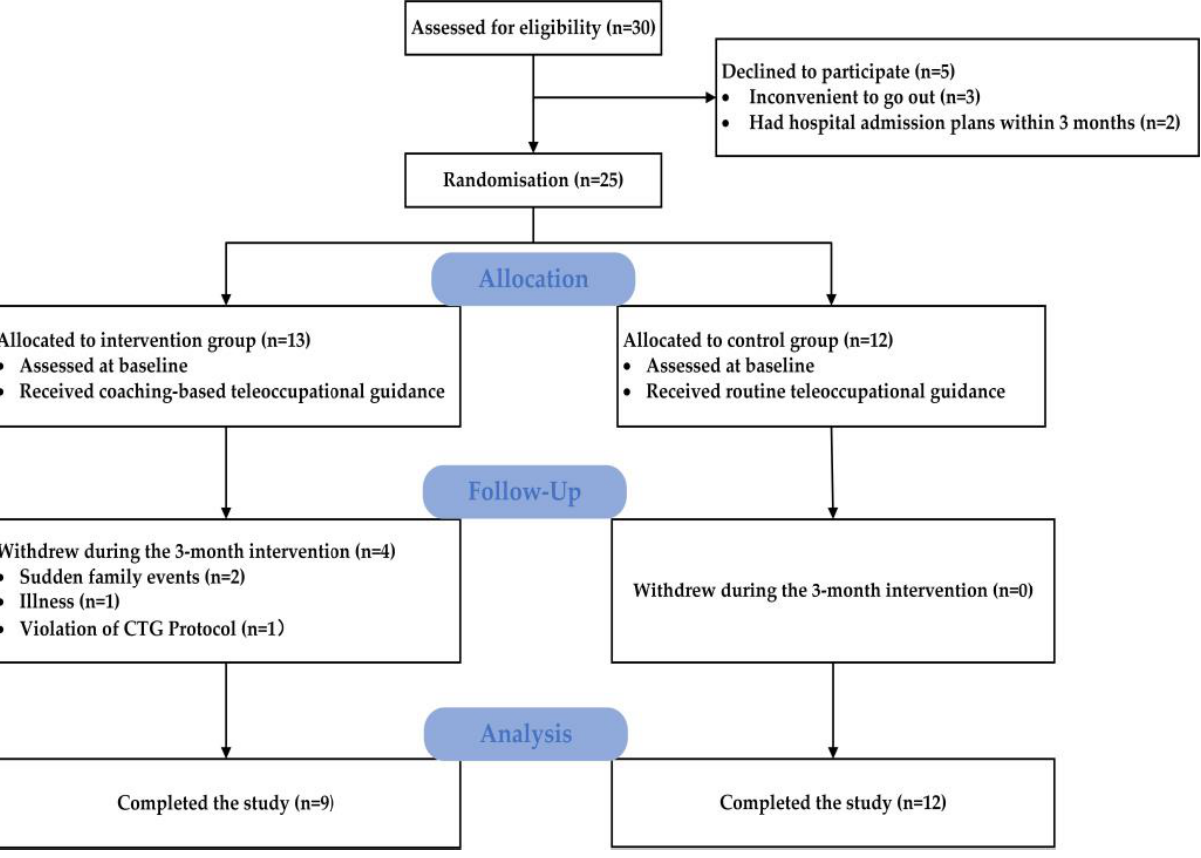
Figure 1. Flow chart of the study design. Table 1. Basic characteristics and effectiveness outcome measures for stroke survivors and caregivers.